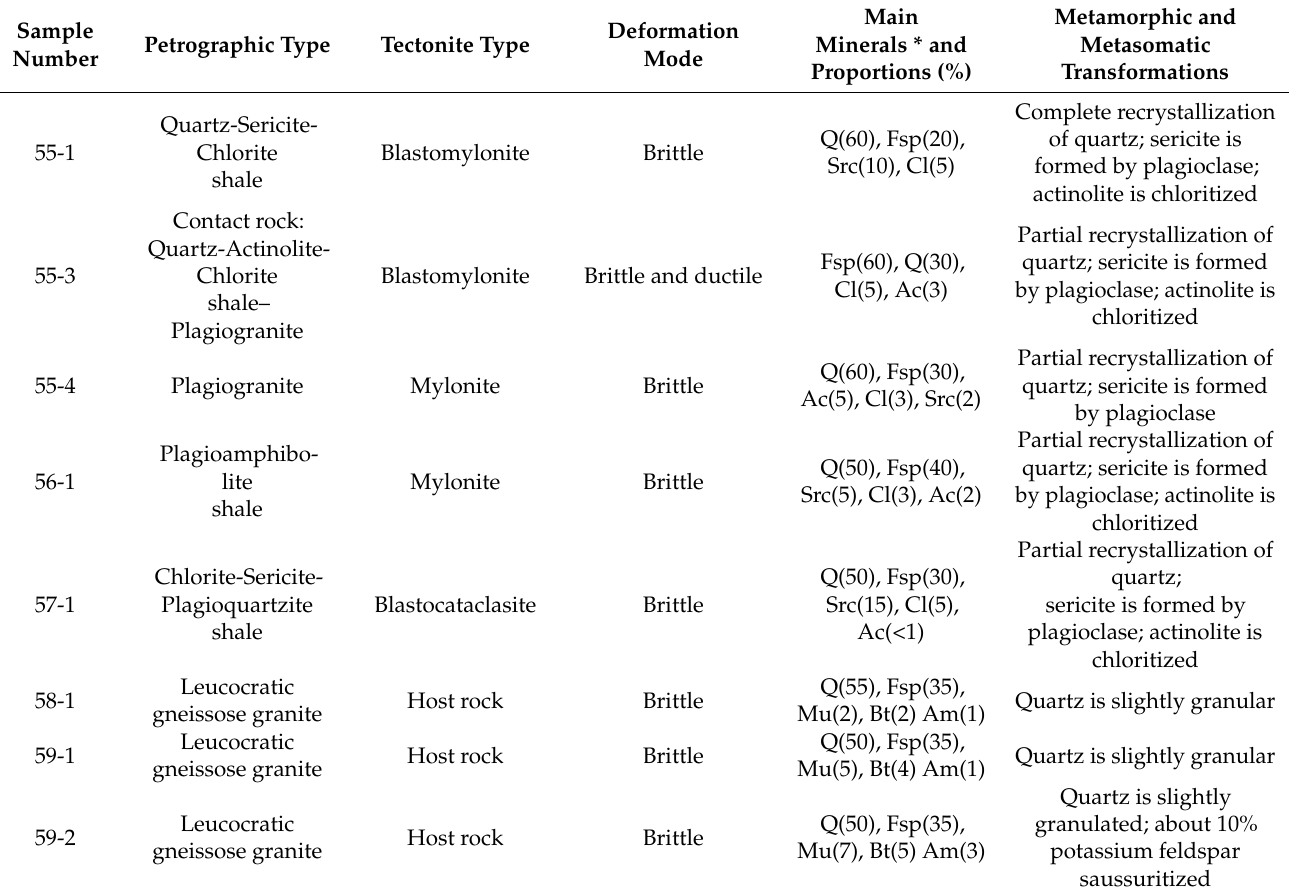
Table 1. Petrographic description of rock